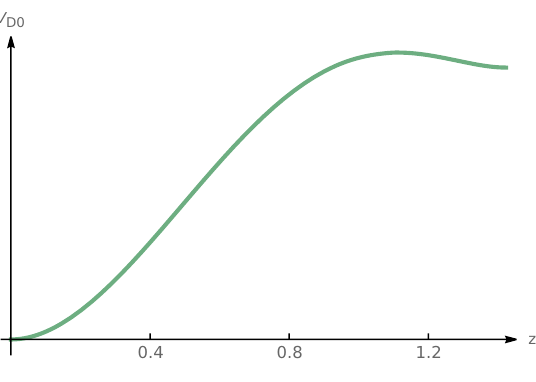
Figure 3 . − The D0-brane potential, V D0 . It can be seen numerically that the unstable equilibrium point only exists when F = 0 and that it gets closer to z 4 6